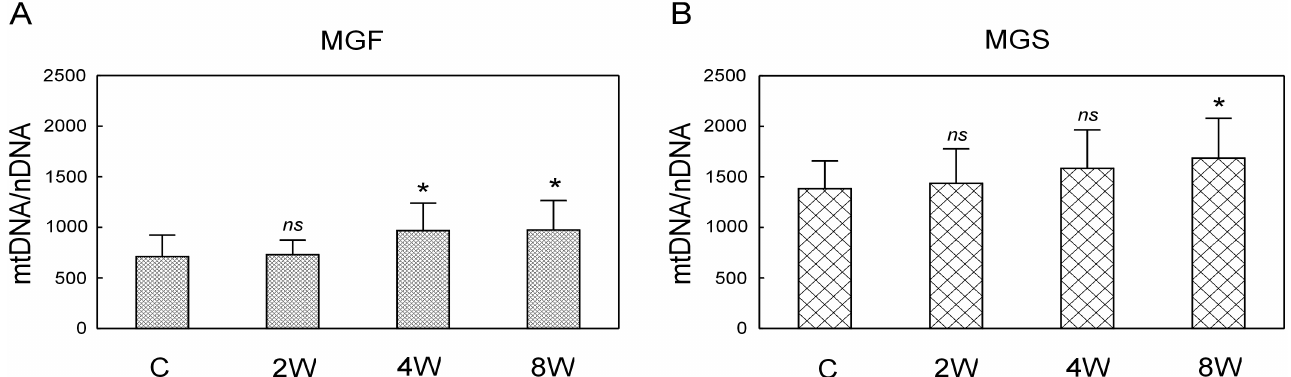
Fig 7. mtDNA copy number in the MGF and the MGS in control and trained animals. Mitochondrial DNA copy number (mtDNA/nDNA ratio) in the fast part of the medial gastrocnemius (MGF, panel A) and the slow part of the medial gastrocnemius (MGS, panel B) after 2, 4 and 8 weeks of endurance training. Data are presented as mean + SD. One-sided p-value represents the statistical significance of the training period (2, 4 or 8 weeks) with respect to the control group (Dunnett’s post hoc test) (S11 File). The symbols (cid:3) denote values significantly different: (cid:3) p < 0.05, (cid:3)(cid:3) p < 0.01, (cid:3)(cid:3)(cid:3) p < 0.001.